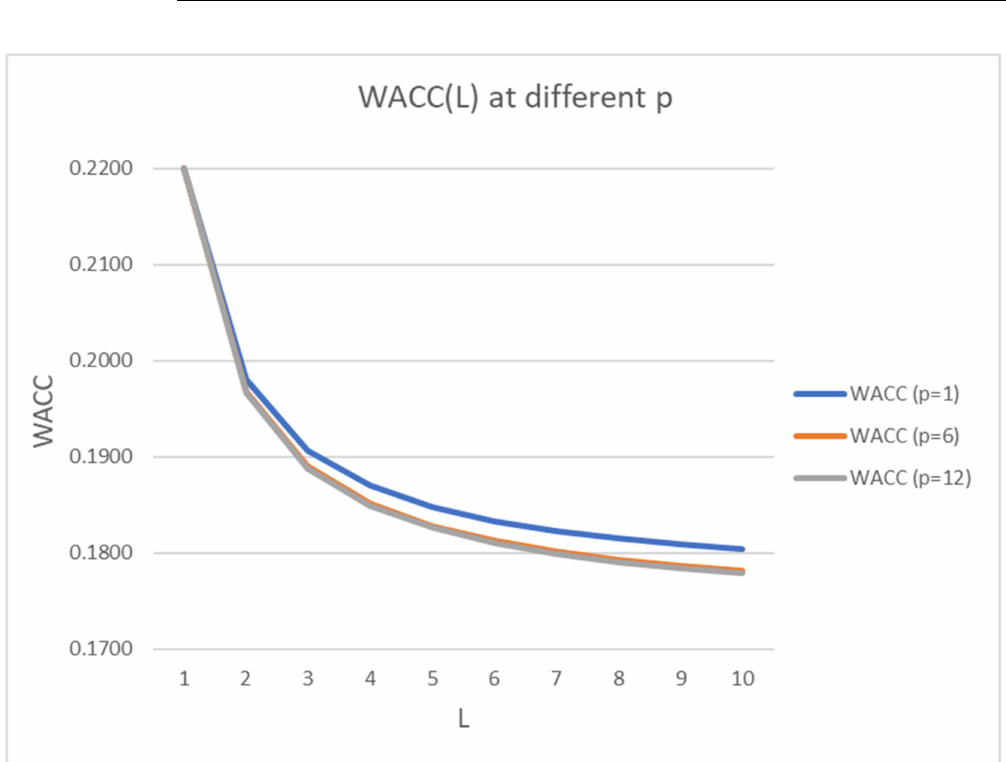
Figure 1. Dependence of the weighted average cost of capital, WACC, on leverage level L at different frequencies of payments of tax on profit, p = 1; 6;